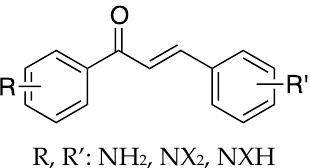
Figure 2. Aminochalcones.